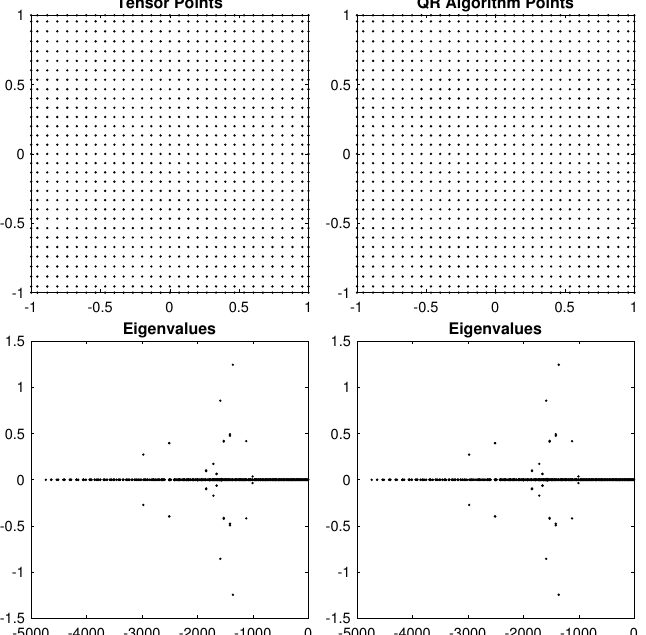
Figure 10. Tensor product points and resulting MCpQR algorithm points with Dirichlet Lapla- cian eigenvalues.